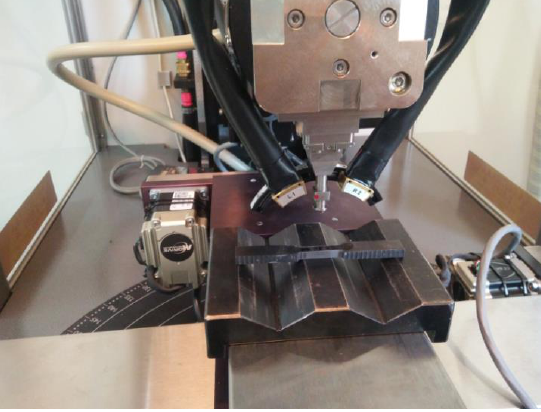
Figure 2. Residual stress measurement by X-ray.